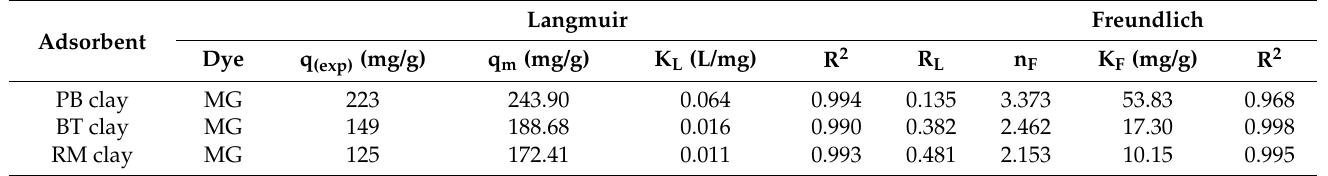
Table 4. Langmuir and Freundlich parameters for the adsorption of MG onto NICs adsorbents. Langmuir Freundlich Adsorbent